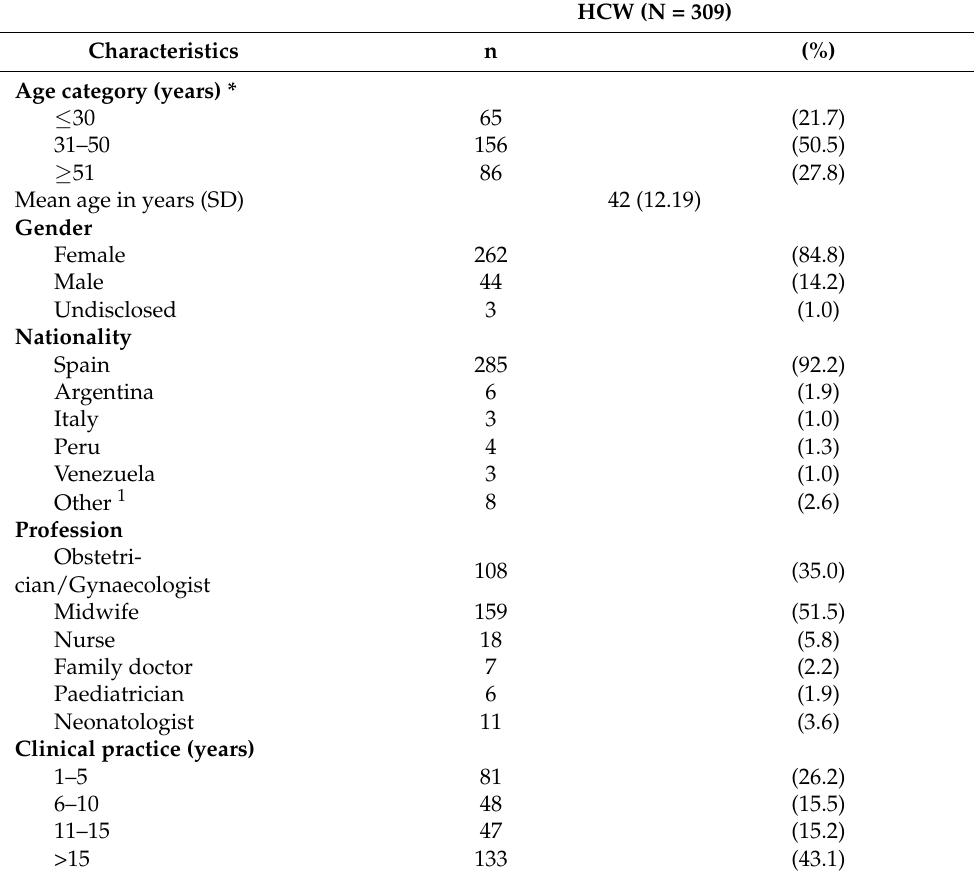
Table 2. Socio-demographic characteristics of HCWs participating in the